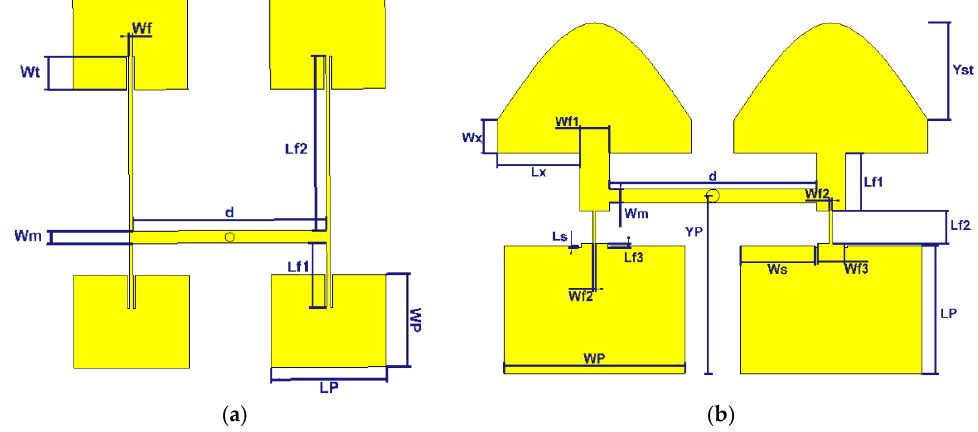
Figure 12. Configuration of the ( a ) conventional 2 × 2 antenna array ( b ) proposed 2 × 2 antenna